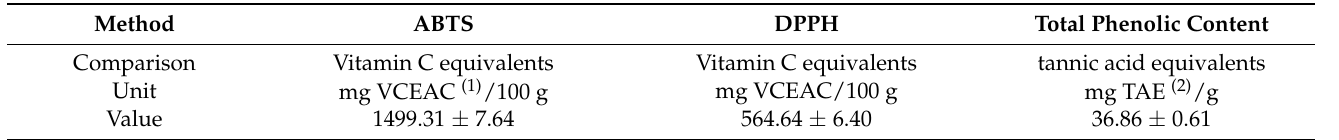
Table 1. Antioxidant effect of NES-CBE.